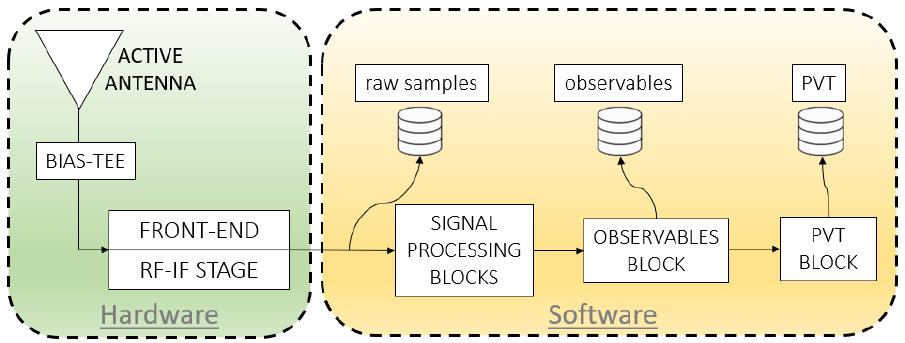
Figure 1. General Software-Defined Receiver (SDR)